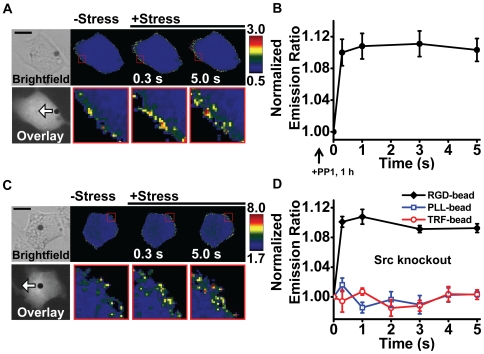
Stress-induced Rac activation is independent of Src activity.(A) Time-lapse images of a representative smooth muscle cell transfected with the Rac biosensor and pretreated with a specific Src inhibitor, PP1 (10 µM for 1 hr), before stress application. Florescence resonance energy transfer (FRET) changes were observed within 0.3 s after stress application as shown in the inset with enlarged cell periphery. White arrow indicates magnetic bead movement direction when a stress of 17.5 Pa is applied. Scale bar  = 10 µm. (B) Average data showing rapid Rac activation by stress even though Src was inhibited by PP1. (n = 6 cells, mean +/− s.e.). (C) Time-lapse emission ratio images of the Rac biosensor in response to 17.5 Pa stress in a representative Src/Yes/Fyn triple-knockout (SYF−/−) MEF cell. The inset with the enlarged area of the cell periphery shows rapid activation of Rac. White arrow indicates RGD coated magnetic bead movement direction. Scale bar  = 10 µm. (D) Probe specificity of Rac activation. Normalized YPet/CFP emission ratio shows that Rac activation is induced in SYF−/− mouse MEFs by mechanical stress applied via RGD-coated magnetic beads that bind specifically to integrin receptors (n = 6 cells). Although the PDGF-induced Rac activation is known to be downstream of Src [4], knocking-out Src did not prevent Rac activation by stress. However, application of the same magnitude of stress at 17.5 Pa with beads coated with transferrin (TRF-bead) or poly-L-lysine (PLL-bead) did not activate Rac (TRF-bead, n = 4 cells; PLL-bead, n = 4 cells). Mean +/− s.e.